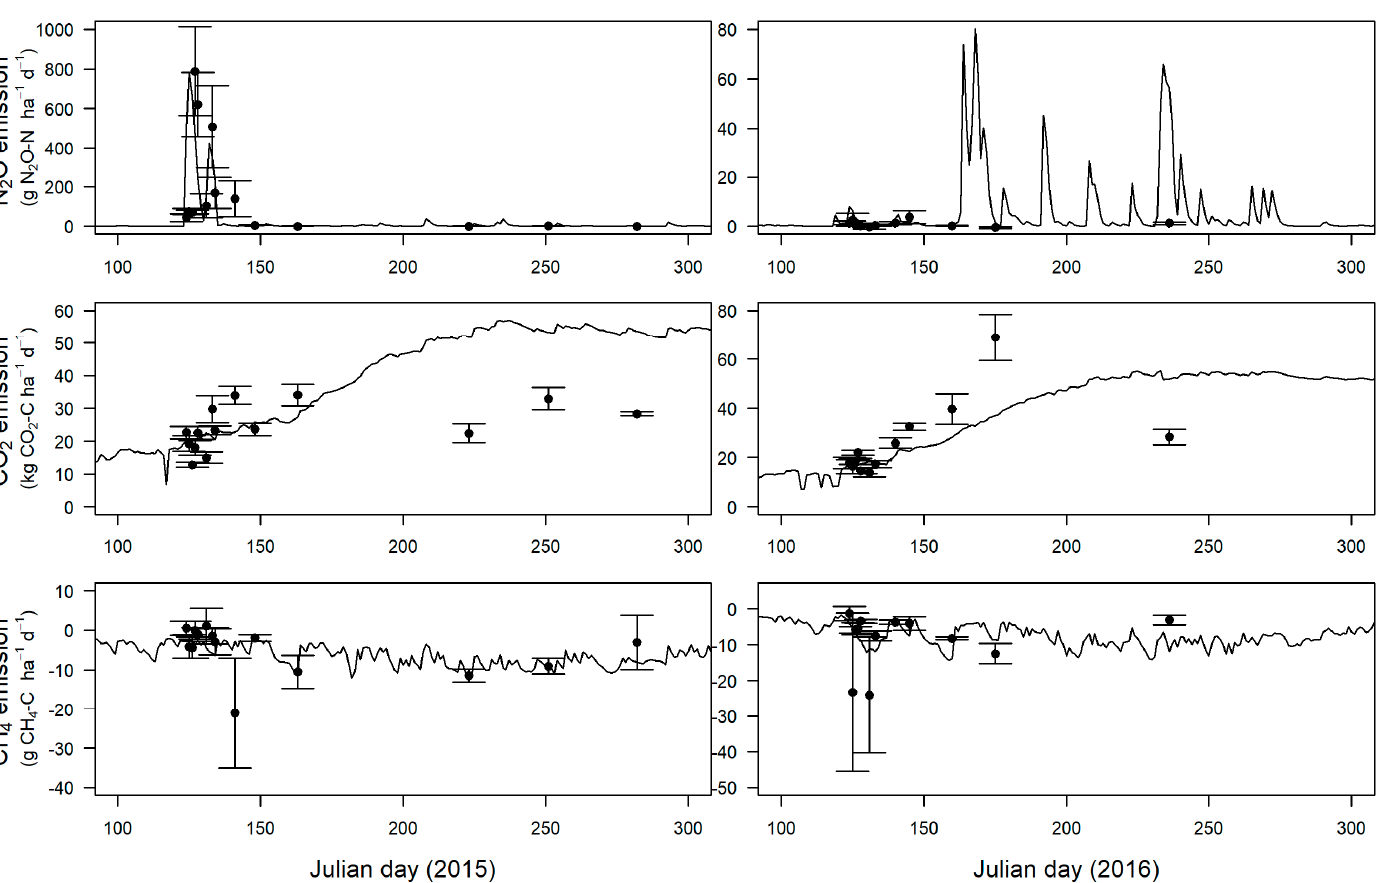
Figure 2. Measured (filled circle) and simulated (solid line) N 2 O, CO 2 and CH 4 emissions from soils of the nitrogen treatment for 2015 and 2016 growing seasons. Error bars are standard deviations for 5 replicates.